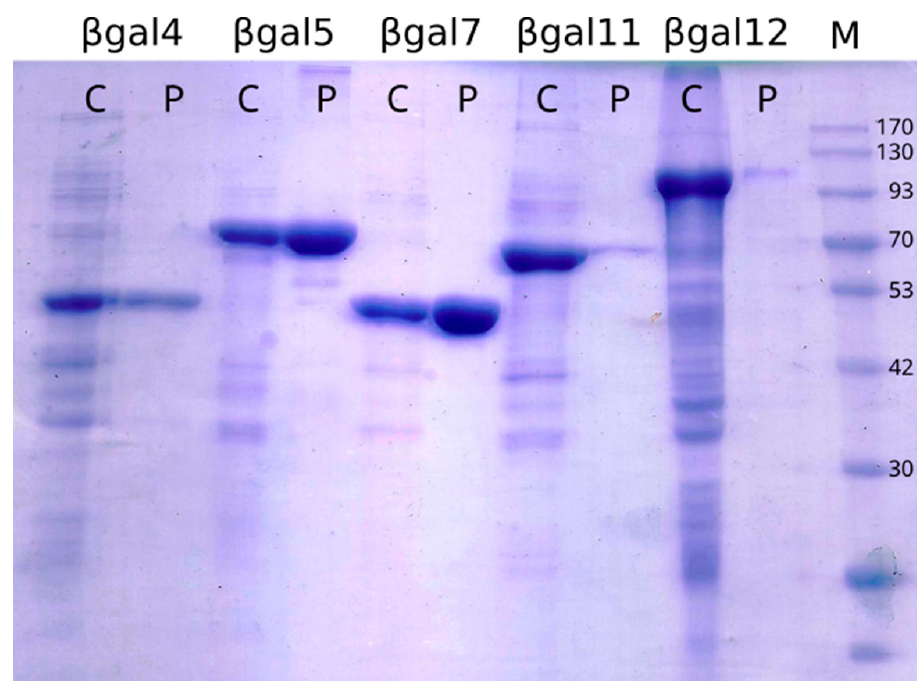
Figure 2. SDS-PAGE of β -galactosidases expression. Crude extracts (C) and affinity purified (P) samples. M, molecular weight marker.